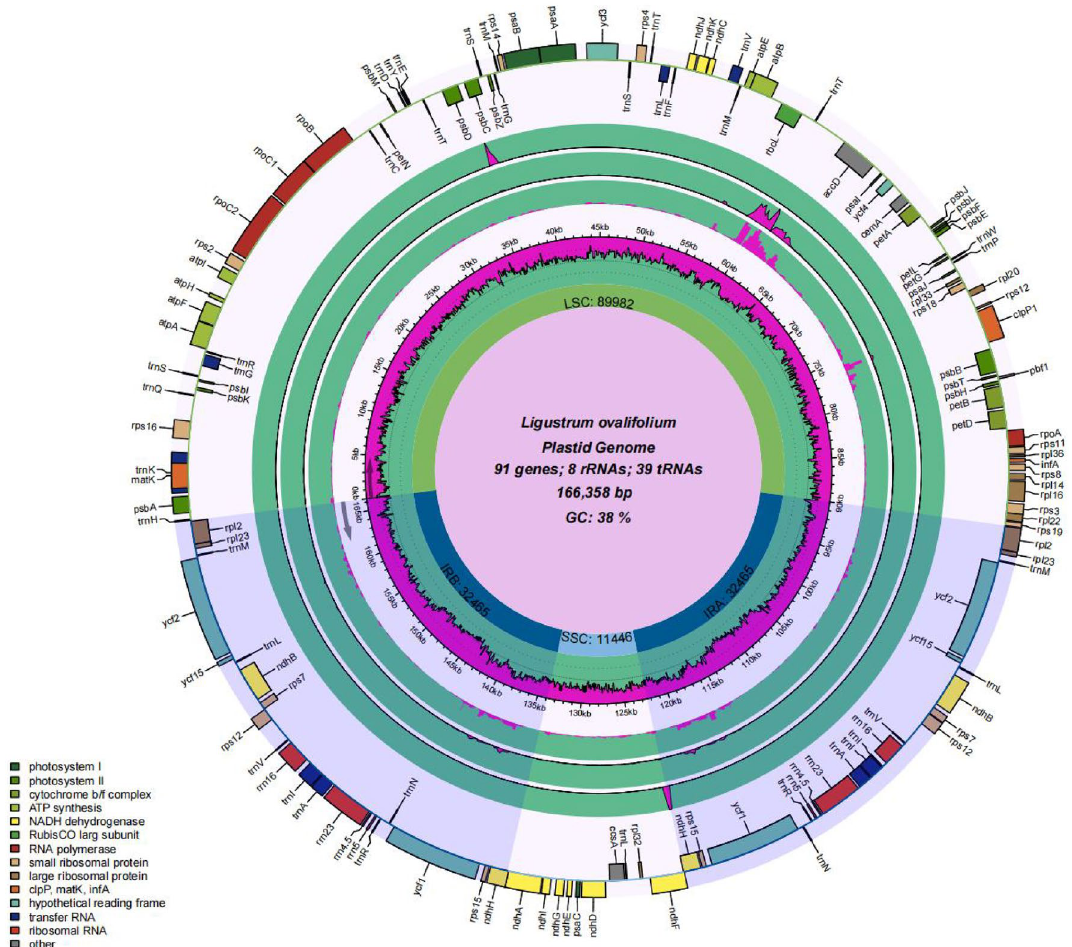
Figure 1. Chloroplast genome maps of four Ligustrum species. The species name and specific information regarding the genome (length, GC content, and the number of genes) are depicted in the center of the plot. From outside to inside, the outermost: L.ovalifolium ’Aureum’, and then followed by L. sinense, L. obtusifolium and L. vicaryi compared with L.ovalifolium ’Aureum’,